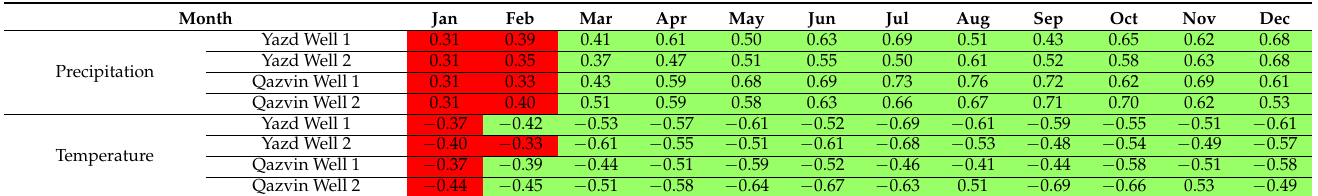
Table 9. Correlation coefficient between changes in groundwater level and meteorological